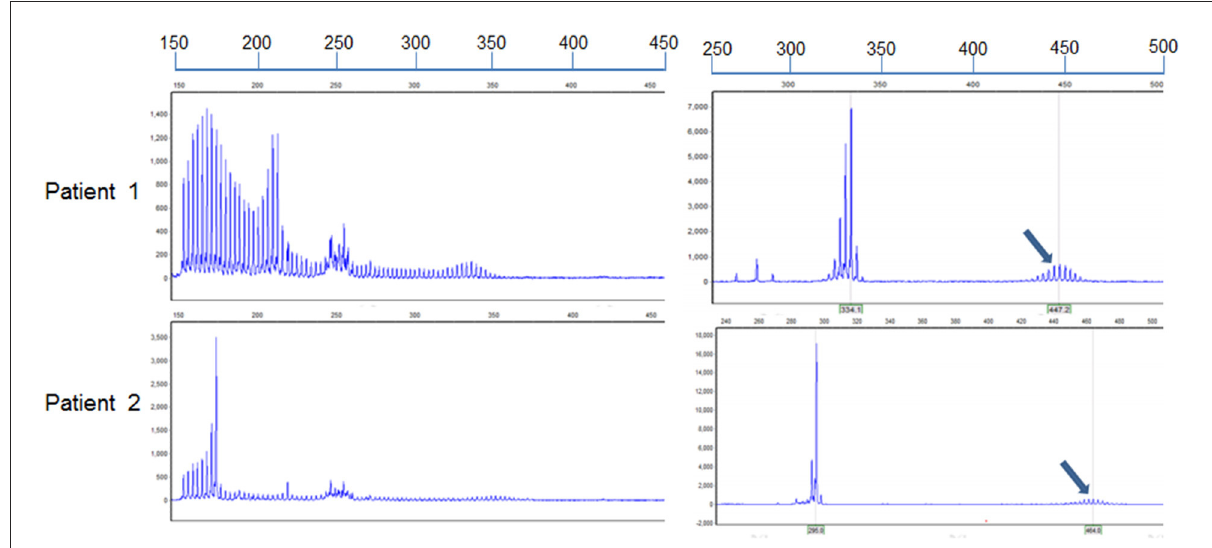
FIGURE4 Identification of alleles with GGC repeat expansions in the two sisters. Repeat-primed PCR and fluorescence amplicon length analysis of both patients showed GGC repeat expansions. The number of repeats was determined by comparing the length of the highest signal peak of the expanded allele (arrows) to that of the human reference gene sequence as previously described (6). The formula to determine repeat size was ([“length of the highest signal peak of the expanded allele” bp – 185 bp] / 3 bp + 13). The assumed length of the PCR product was 185 bp in accordance with the standardized GRCh38.p13 human genome, containing the reference (GGC)9(GGA)2(GGC)2 sequence ( n =